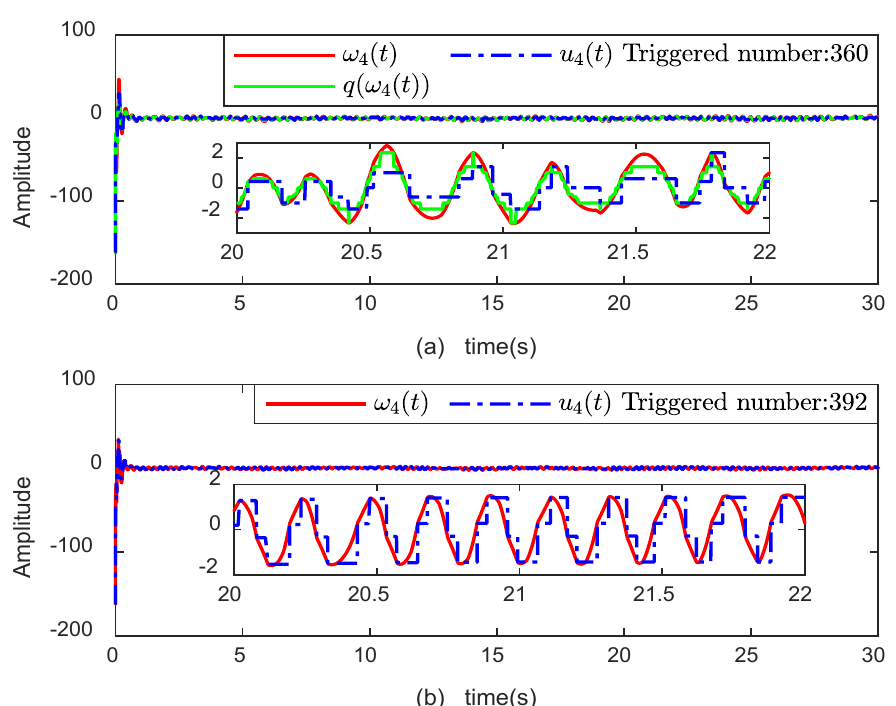
Figure 11. The trajectories of ω 4 , q ( ω 4 ) , and u 4 . ( a ) with quantized control. ( b ) without quantized control.